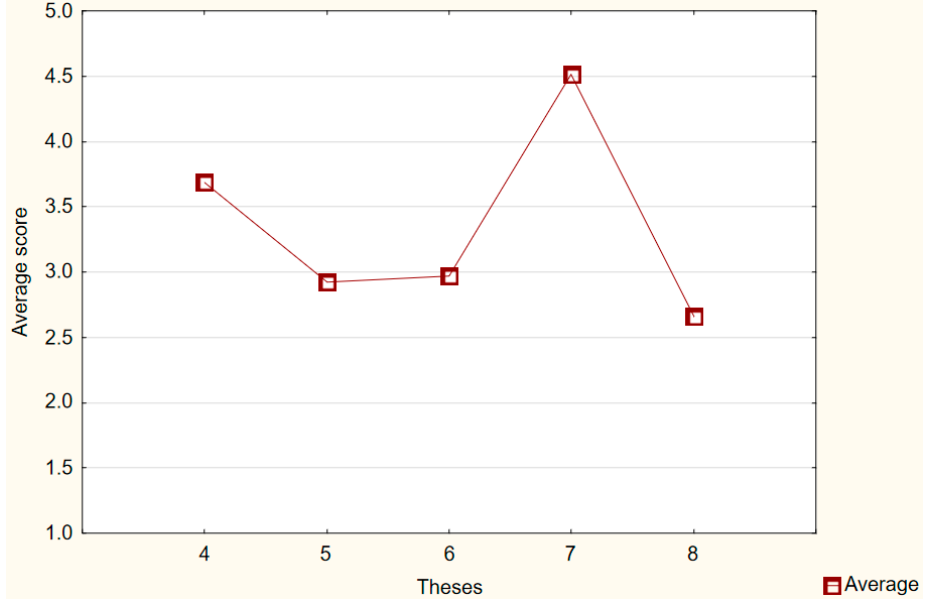
Figure 7. Average ratings of theses relating to the energy sector.